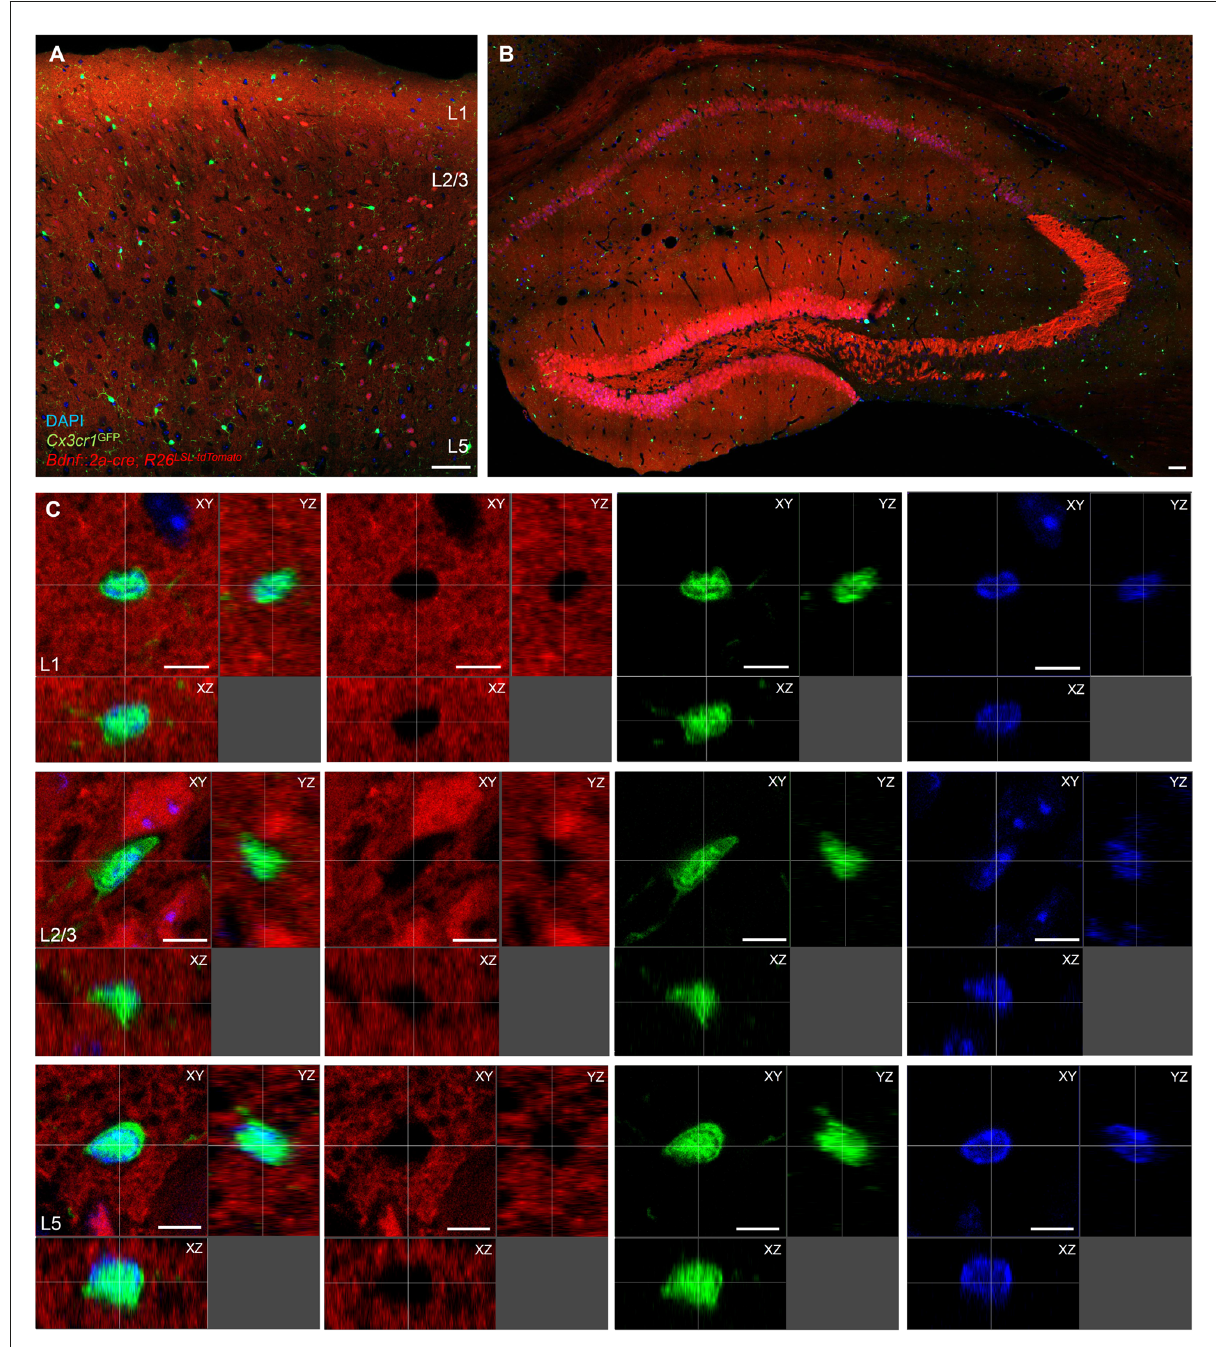
FIGURE5 Microglia do not express the reporter for BDNF transcription Bdnf::2a-cre ; R26 LSL − tdTomato . (A) Low magnification image of a coronal section from the Bdnf::2a-cre/+ ; R26 LSL − tdTomato / + ; Cx3cr1 GFP / + mouse reporter line at P60. (B) Low magnification image of a hippocampal section. (C) Representative three-dimensional images of GFP-labeled microglia at high magnification showing the absence of tdTomato signal within GFP-labeled microglia. Scale bar: (A,B) : 50 µ m, (C) : 10 µ m.